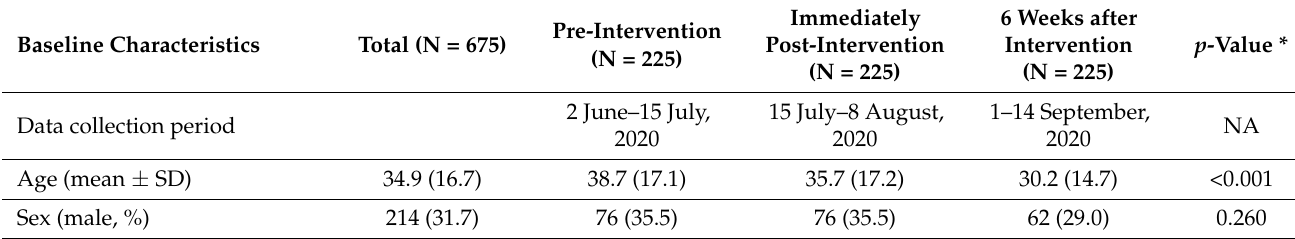
Table 1. Baseline characteristics of patients in the three phases of the study.